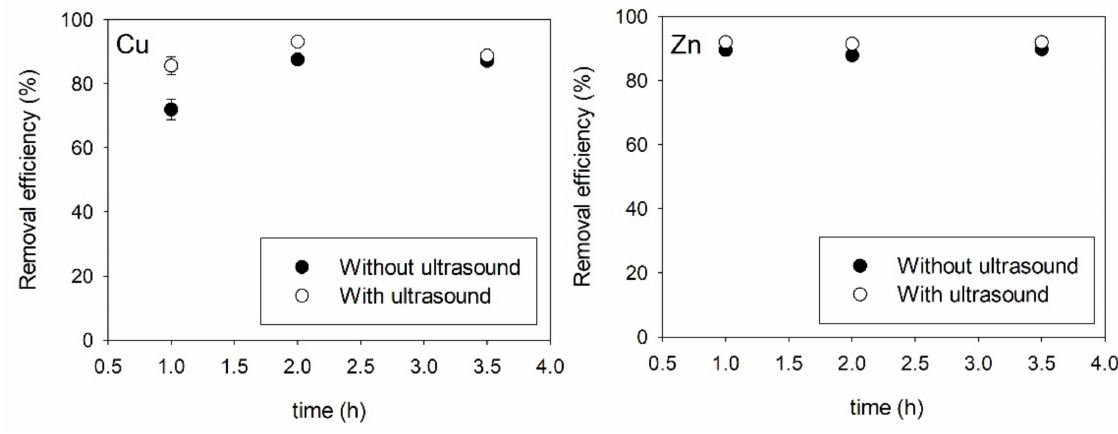
Figure 4. Comparison of removal efficiencies with and without ultrasound process when 10% H 2 SO 4 was applied.